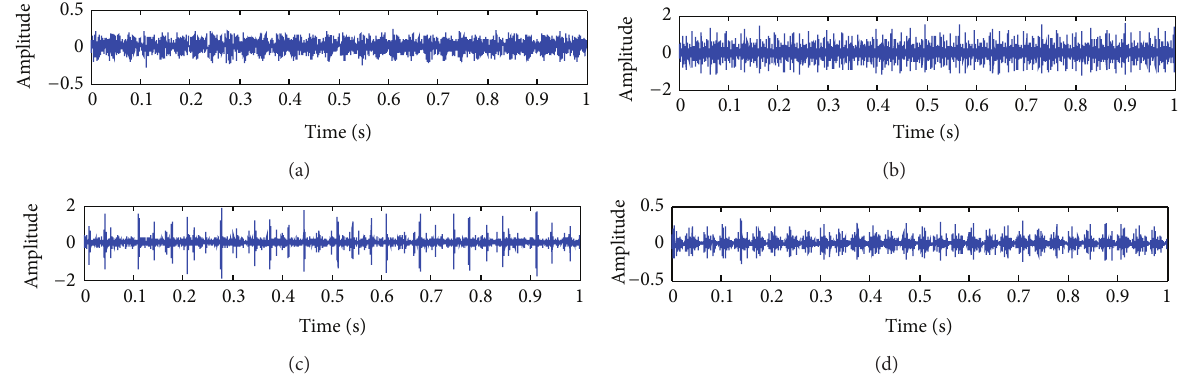
Figure 6: Vibration signals of rolling bearings under different defect sizes: (a) normal, (b) 0.18 mm hole, (c) 0.36 mm hole, and (d) 0.53 mm hole (speed: 1797 rpm, load: